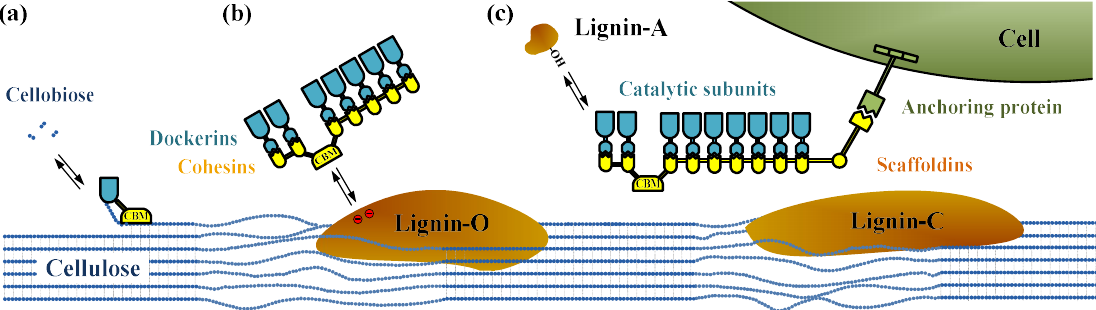
Figure 2. Cellulosomal assemblies and the hypothetical interactions with pretreated substrates. ( a ) free enzymes; ( b ) cell-free scaffodins; and ( c ) on cell wall. Lignin-O: sulfite treated; Lignin-A: dissolved; and Lignin-C: condensed lignin.